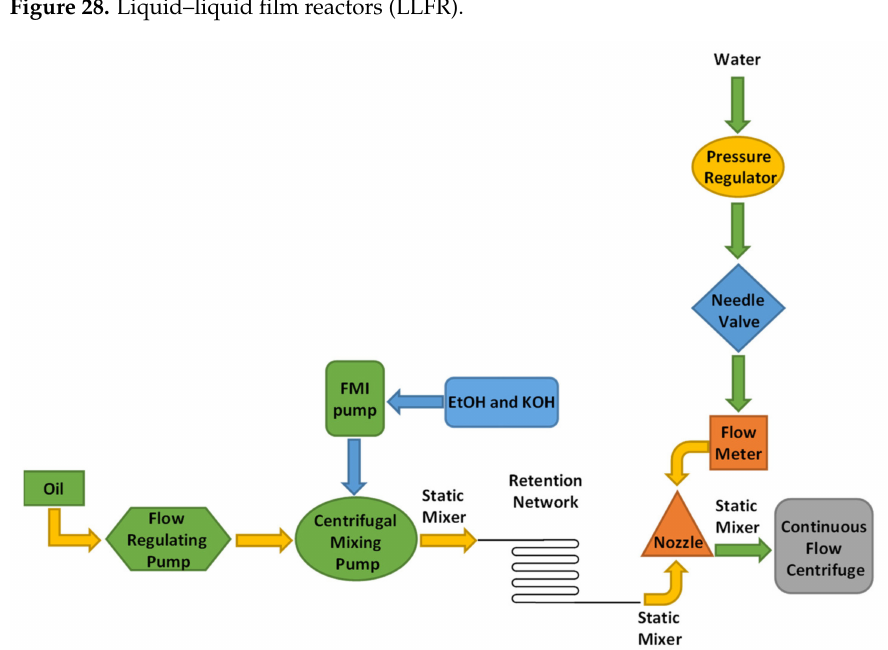
Figure 29. Flow path for the continuous flow